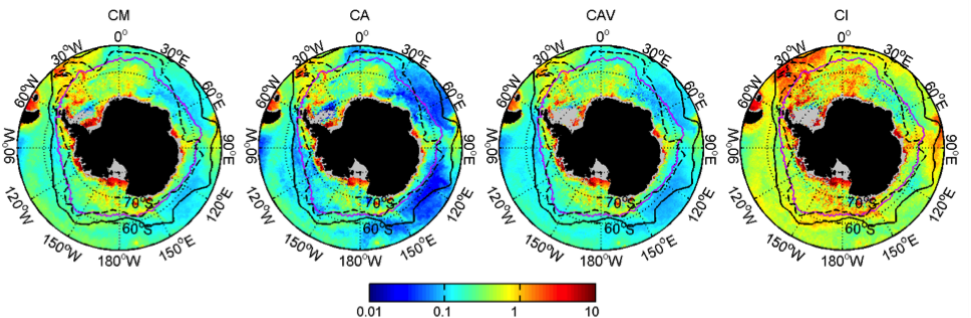
Figure 5. Same as Figure 3, but for Dia-Chla maximum (CM), Dia-Chla amplitude (CA), Dia-Chla average (CAV) and Dia-Chla integrated over the growth duration (CI). Units are in mg · m − 3 .